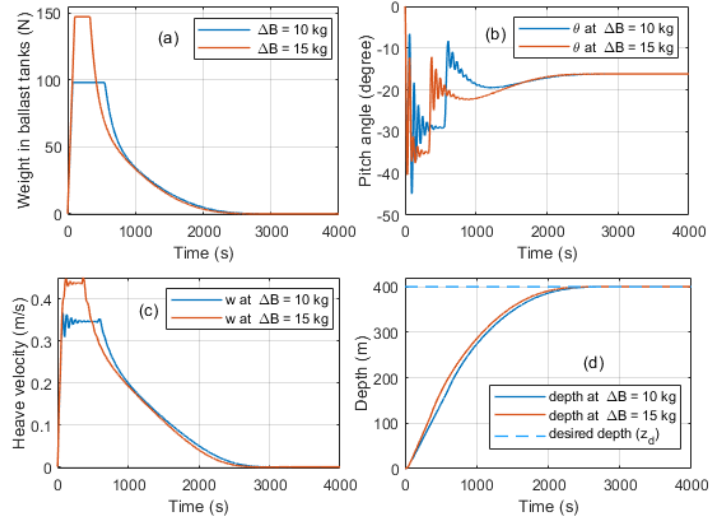
Figure 17. ( a ) Variation of the weight vs. time in ballast tanks, ( b ) pitch angle with time, ( c ) sinking (heave) velocity with time and ( d ) depth with time in closed loop for 4 m length AUV.